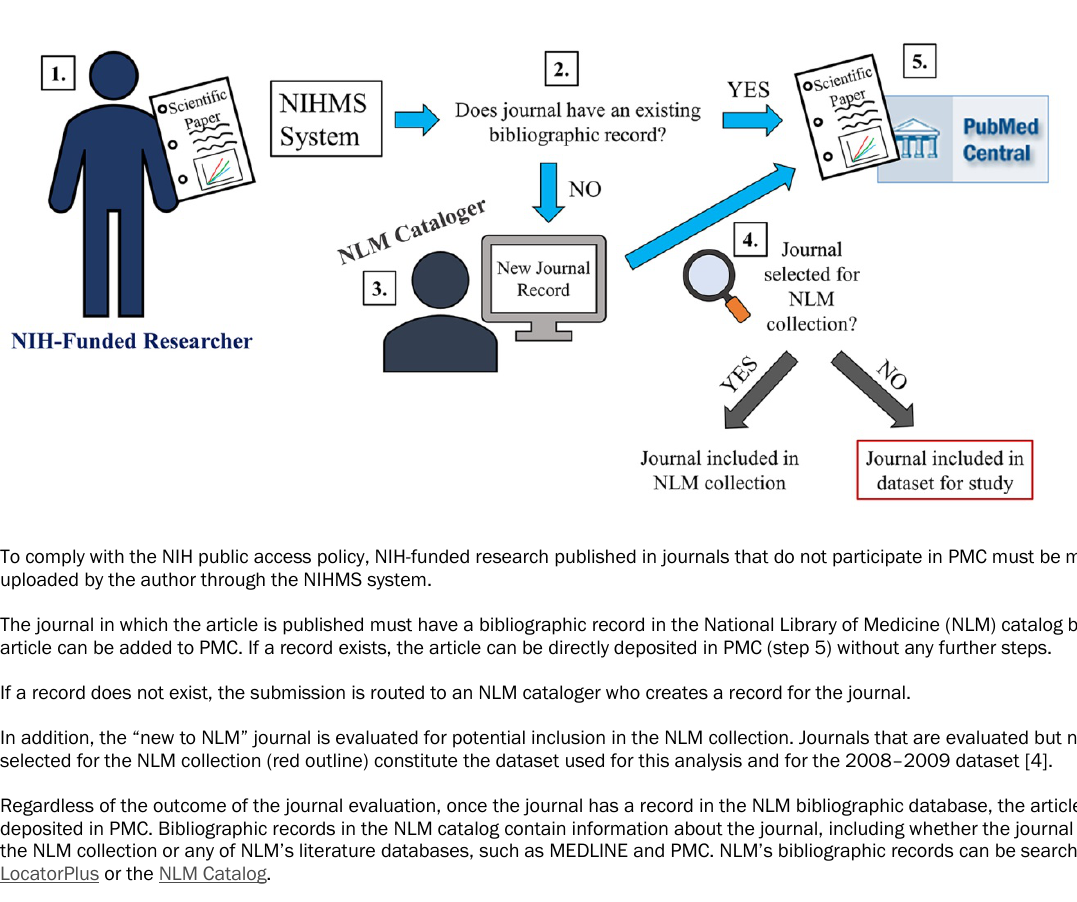
Figure 1 General schematic of bibliographic workflow for articles submitted to PubMed Central (PMC) via the National Institutes of Health Manuscript Submission (NIHMS)